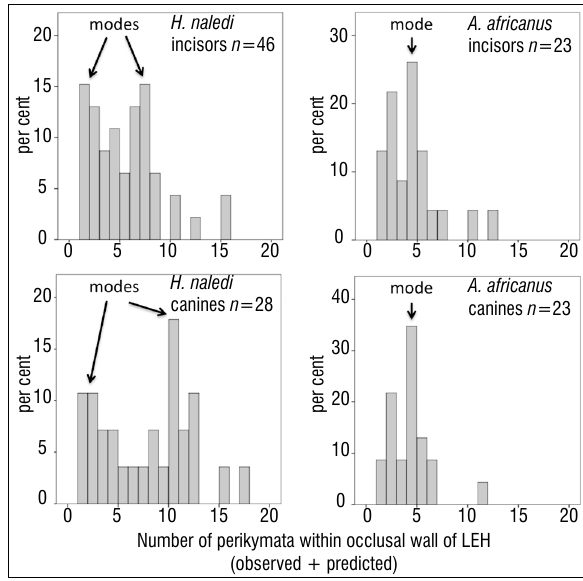
An assumption in this study is that, with caveats noted later, defect depth is a measure of ‘felt stress’. Sustained stress, with no change in intensity, will produce deeper defects. 20 A comparison of defect depth between those of Number of perikymata within occlusal wall of LEH short versus longer duration confirms this phenomenon (‘short duration’ (observed + predicted) median depth = 10.9 µm, ‘long duration’ median depth = 21.5 µm; z =-5.019, p <0.0001). Consequently, in an analysis of defect depth one Figure 2: Distribution of occlusal wall perikymata counts compared has to separate the sample by defect duration. As shown in Table 5, after among tooth types and taxa. Homo naledi shows bimodal controlling for defect duration, LEH are significantly deeper in canines, distributions while Australopithecus africanus does not.